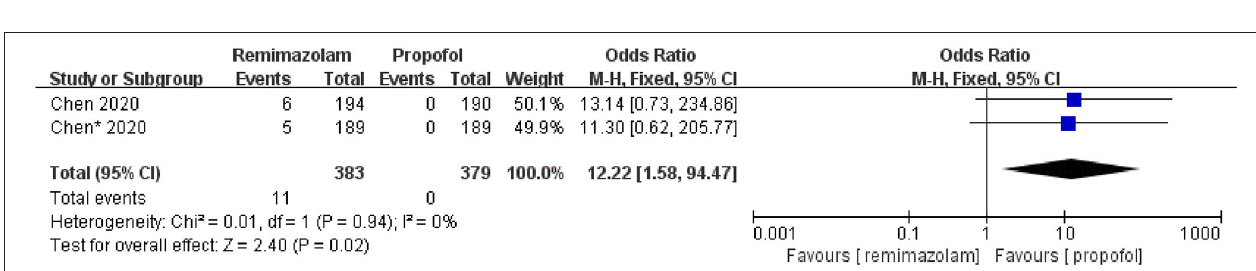
FIGURE 5 | The comparison of sedative efficacy between remimazolam and propofol.